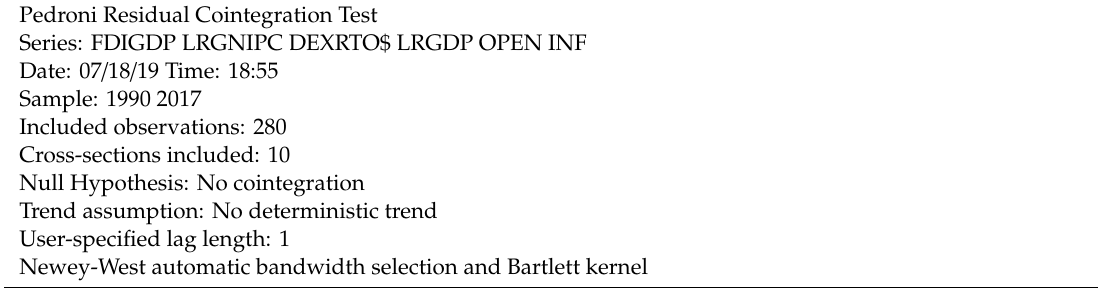
Table A7. Panel Cointegration test to test for presence of